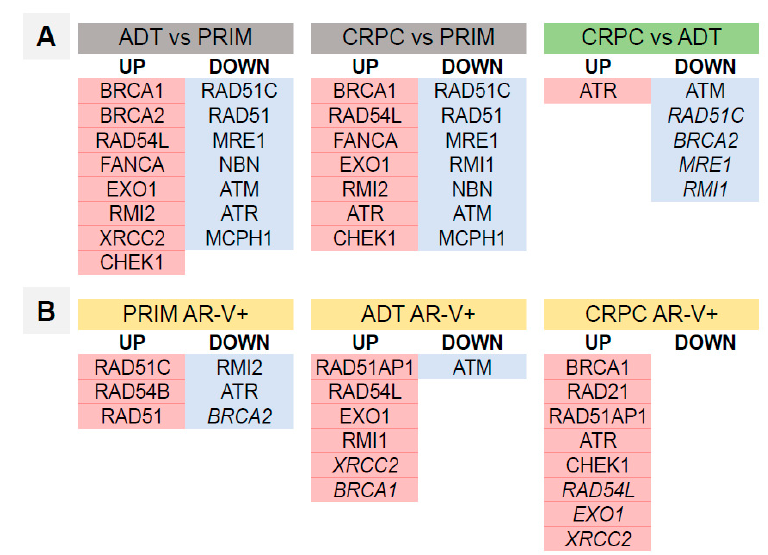
Figure 7. DNA repair genes differentially expressed in samples from different ADT, CRPC and PRIM